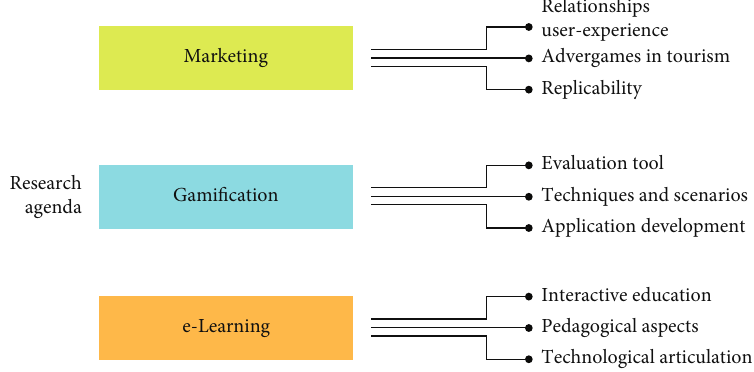
Figure 3: Proposed research